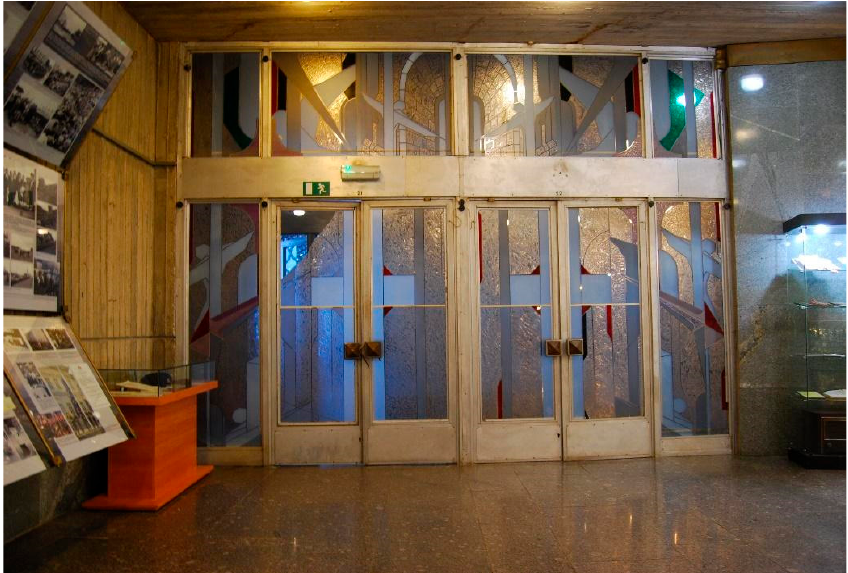
Figure 7. Standard aluminium doors in the memorial complex of the Ninth Fort in Kaunas. Photo by V. Petrulis, 2021.